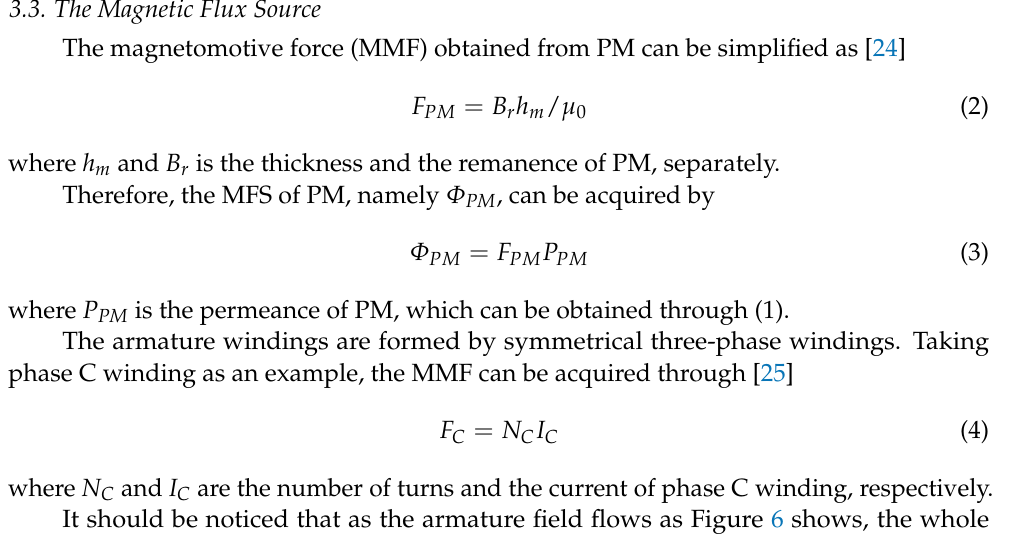
Figure 5. Separation of stator and rotor core: ( a ) One stator segment; ( b ) One rotor segment.